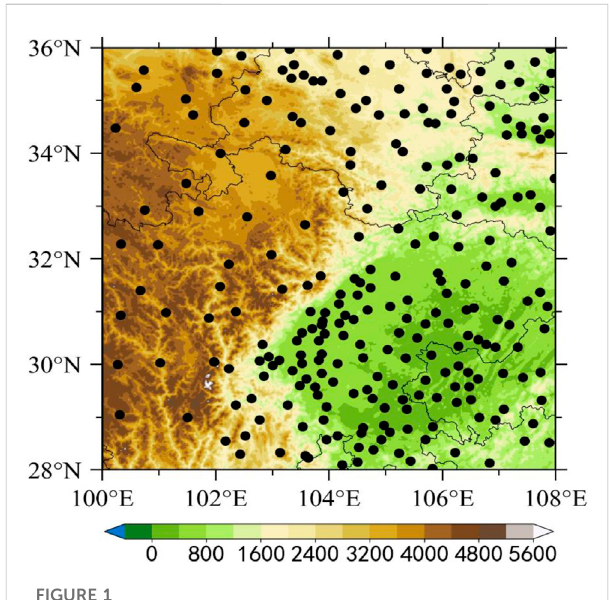
FIGURE 1 Topographic pro fi le and distribution of 250 meteorological stations (dark dots) in